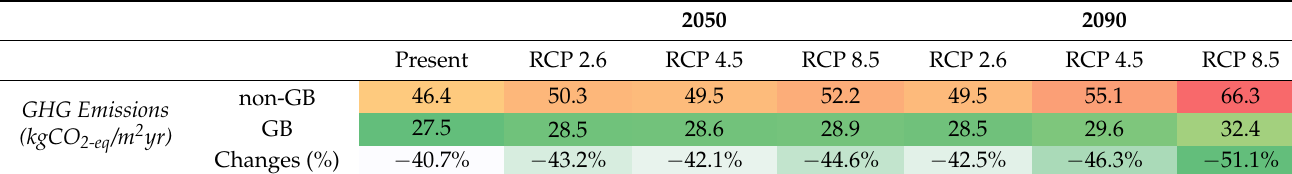
Table 5. Greenhouse gas emissions for the combined energy use for cooling and heating for the GB and